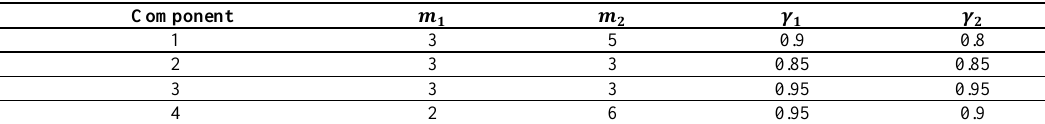
Table 13 . Parameters of the cost function with discounts (Example 2).